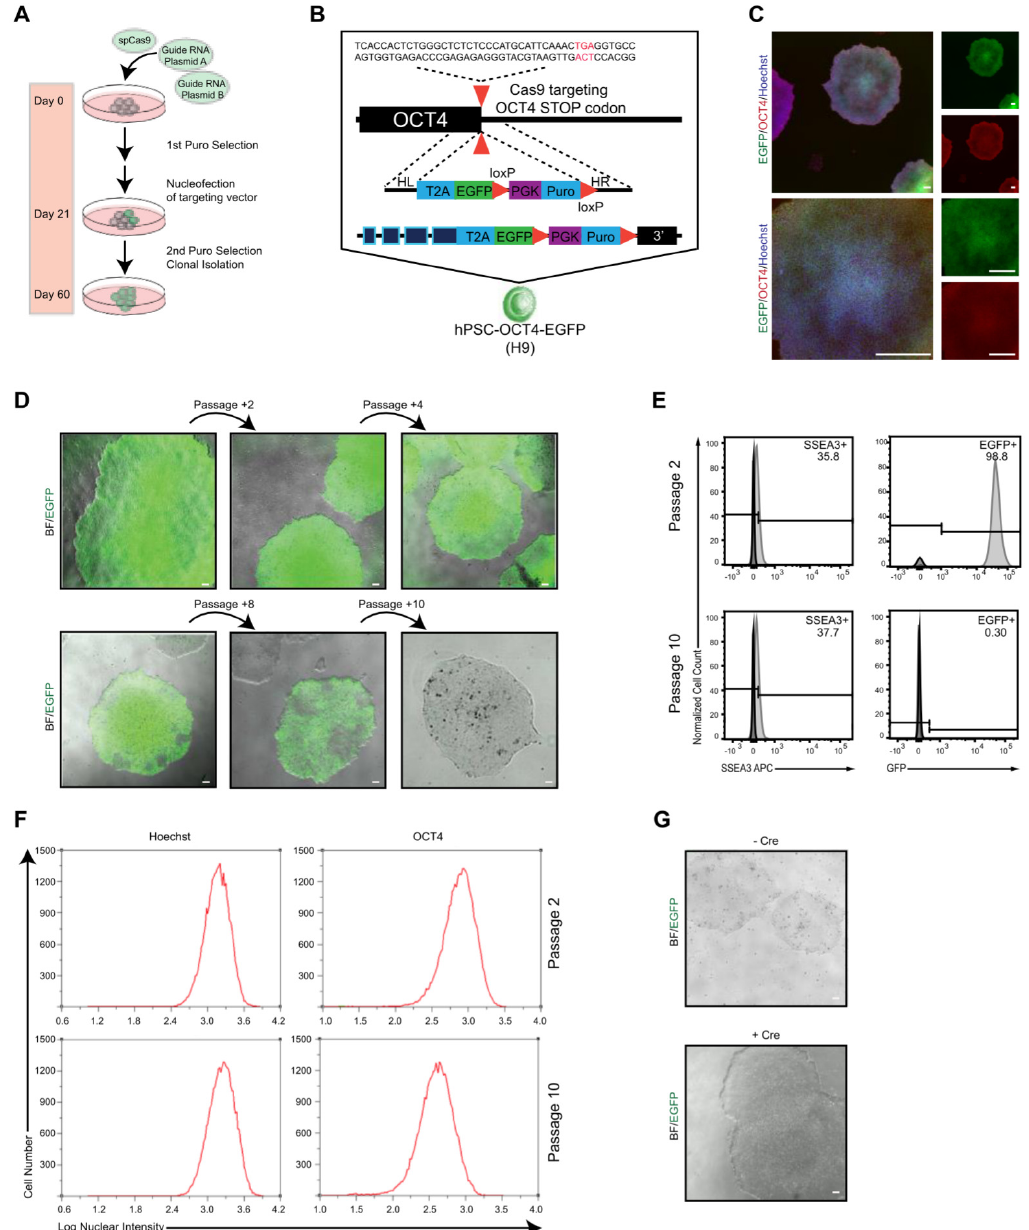
Figure 1. Generation of OCT4–EGFP hPSC line. ( A ) Experimental approach for the generation of EGFP knock-in hPSC lines. ( B ) Schematic overview illustrating the targeting strategy for the OCT4 locus. Homologous recombination between the human OCT4 and OCT4-2A-EGFP-LoxP- PGK-Puro-LoxP was promoted by CRISPR/Cas9. Puro, puromycin. ( C ) Immunofluorescence images of undifferentiated hPSC–OCT4–EGFP colonies, cultured in feeder-free condition in mTeSR medium, exhibiting typical cell morphology, and expressing OCT4 (red) and EGFP (green). Nuclei are stained with Hoechst (blue); scale bars = 80 µ M and 240 µ M, respectively. ( D ) Microscope images showing colony morphology and marker expression of hPSC–OCT4–EGFP cultures after induction and fluorescence-activated cell sorting (FACS) over time with EGFP expression decrease. ( E ) Typical flow histograms show EGFP and SSEA-3 expression levels of hPSC–OCT4–EGFP at early passage (passage 2) and several weeks later (passage 10). ( F ) Histograms show nuclear intensity and frequency of Hoechst + and OCT4 + cells at early passage (passage 2) and several weeks later (passage 10). ( G ) Microscope images showing colony morphology and EGFP expression of hPSC–OCT4–EGFP cultures before and after Cre recombinase